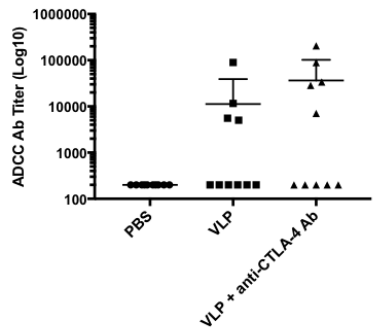
Figure 7. CTLA-4 blockade increases antibody-dependent cellular cytotoxicity (ADCC) activity. CEM.NKRCCR5 cells were infected with HIVBaL or SIVMac251 infectious molecular clones at an e ff ector to target cell ratio of 10:1 and incubated with serial 4-fold dilutions of mouse sera from each immunization group. ADCC activity was detected by the reduction in luciferase